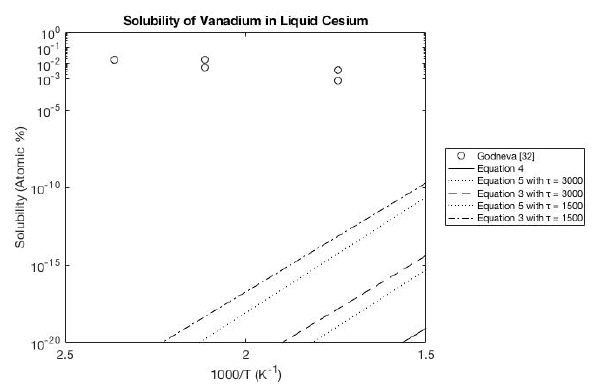
Figure 11. Solubility of iron in liquid cesium.